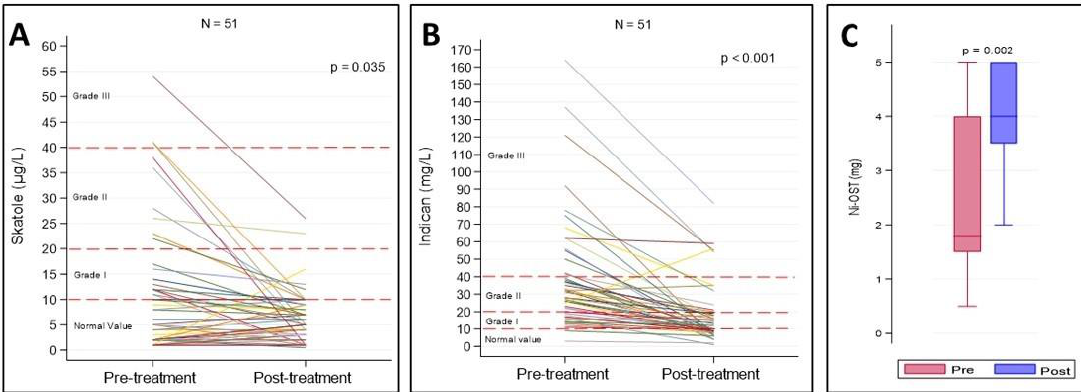
Figure 2. Pre- and post-treatment levels of skatole, indican, and oral Ni stimulation test (Ni-OST). Skatole and indican levels were represented by spaghetti plots ( A, B ) and the amounts of Ni used in the Ni-OST were graphed by boxplots ( C ). Table 4. Comparison of pre- and post-treatment levels of urinary dysbiosis markers and Ni-OST.